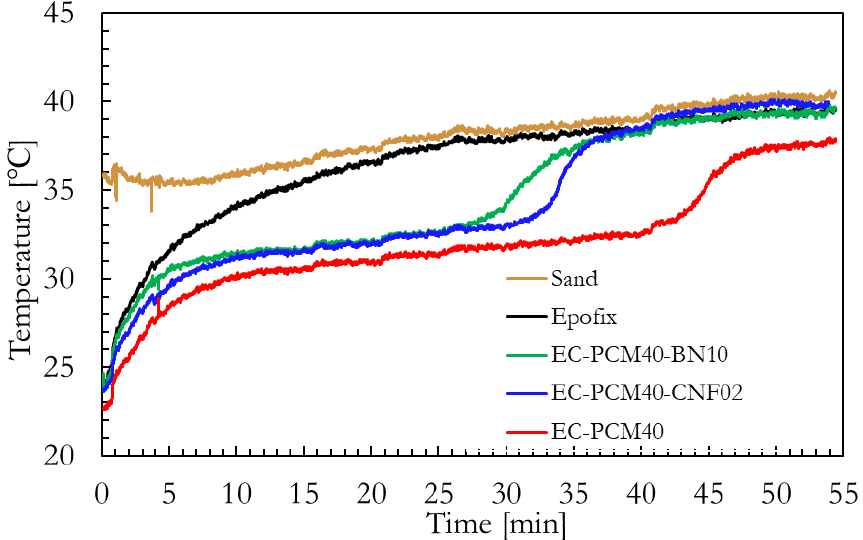
Figure 6 . Temperature vs. time profiles of the epoxy–PCM–filler samples. Figure 6. Temperature vs. time profiles of the epoxy–PCM–filler